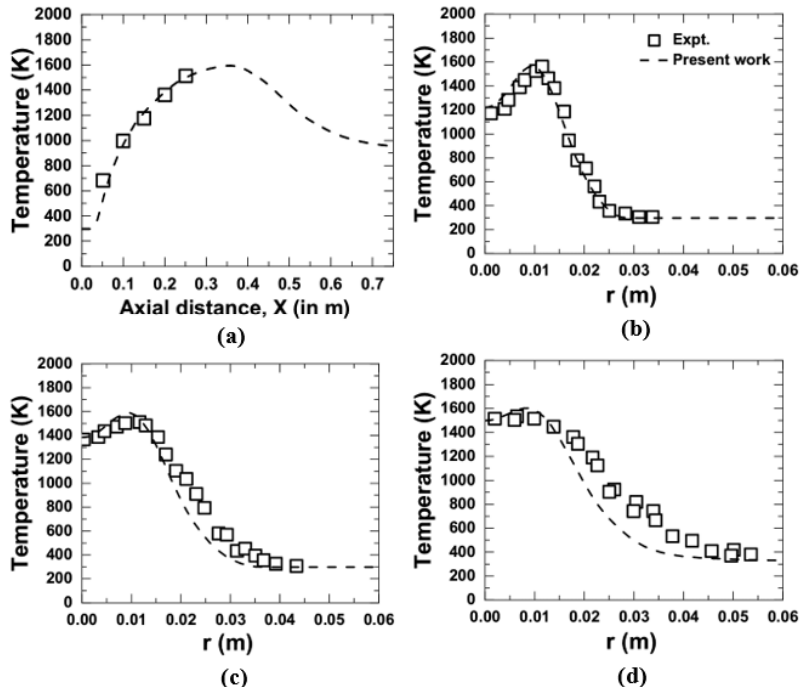
Figure 4. Comparison of temperature obtained from the present numerical model with the measurements [10] at 3 atm; ( a ) axial variation, and ( b ), ( c ), ( d ) radial variation at an axial location of 0.15 m, 0.2 m, and 0.25 m,